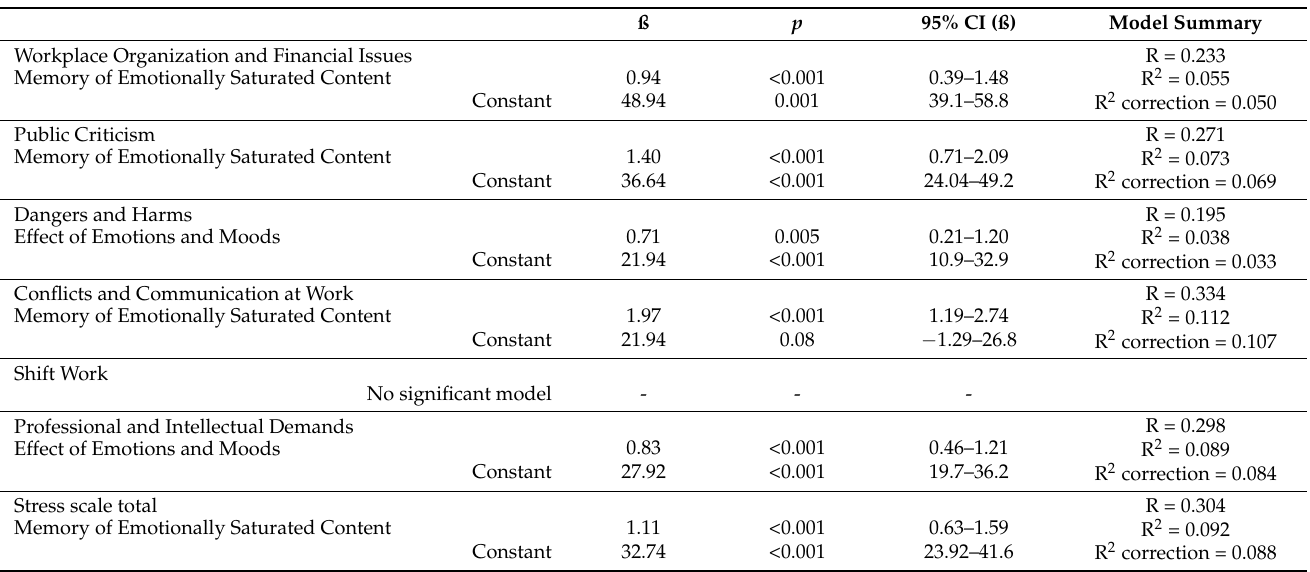
Table 7. Functional correlation between overall experienced stress and emotional regulation and control (multivariate linear regression, Stepwise